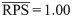
Corresponding predictions for Bhagwanpur block in Bihar (RPS¯=1.00).